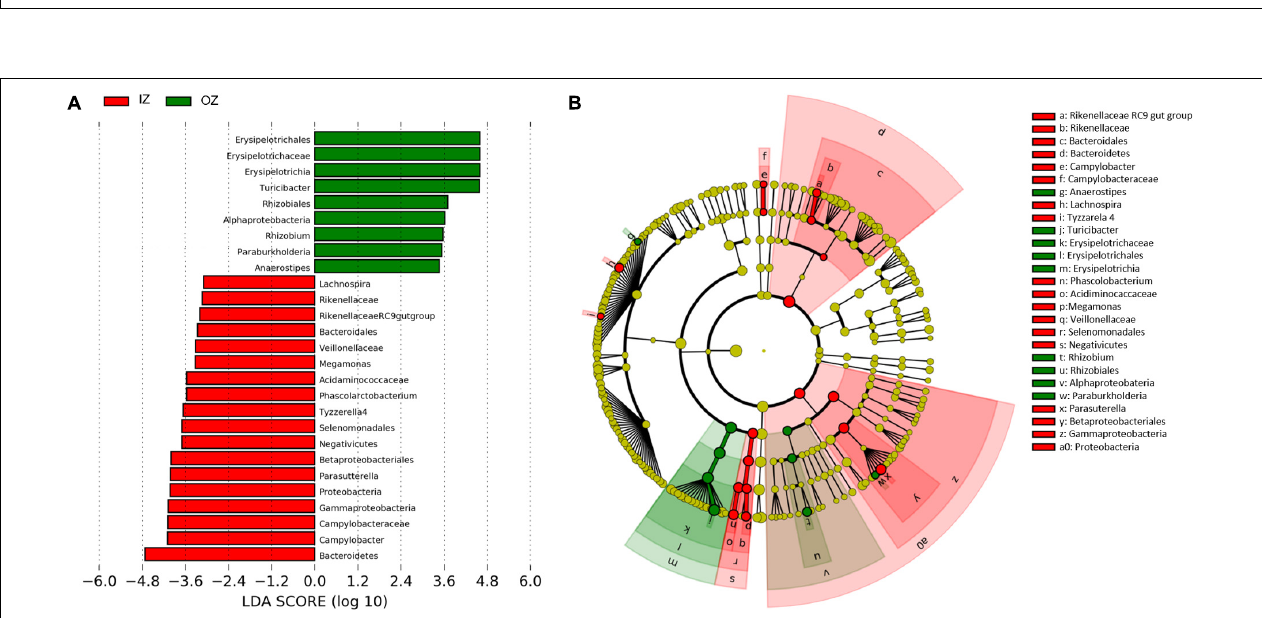
FIGURE 4 | Graphical plot of LEfSe results. (A) Histogram of the linear discriminant analysis (LDA) scores computed for features (bacterial groups) differentially abundant in fecal samples of dogs fed diets supplemented with inorganic (IZ and IZ +) or organic (OZ and OZ +) Zn sources without (IZ and OZ) or with (IZ + and OZ +) the addition of a multi-enzymatic complex from the solid-state fermentation of Aspergillus niger . (B) Taxonomic representation of statistically and biologically differences between fecal samples of dogs fed OZ and OZ + (green) and IZ and IZ + (red) diets; yellow dots are non-significant features (taxa).